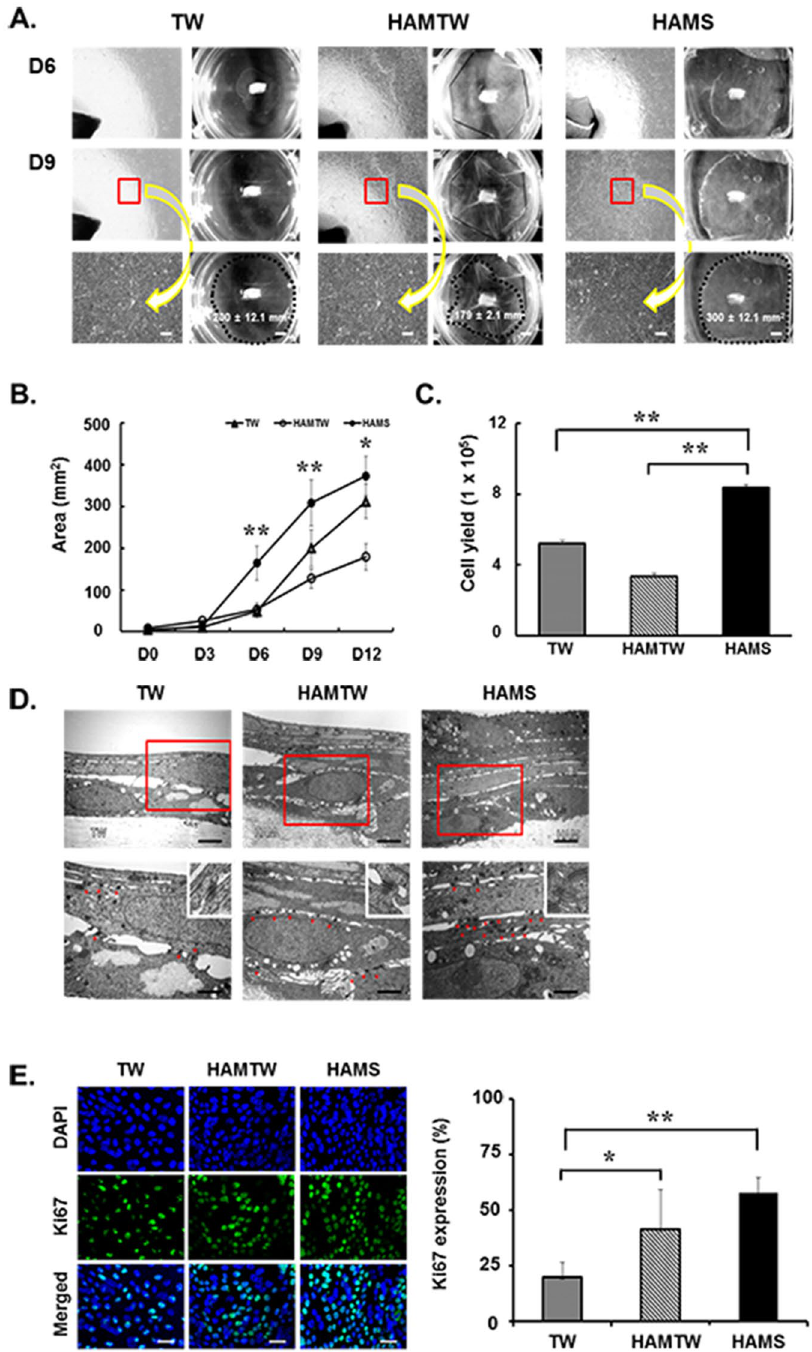
Figure 2. Limbal explant outgrowth sheets on substrate free, HAMTW, and HAMS. ( A ) Representative phase contrast micrographs of limbal explant outgrowth sheets on days 6 and 9 in TW, HAMTW, and HAMS. Bar = 50 µ m. Mean ± SD for six independent experiments from three donors are shown. ( B ) Area of limbal explant outgrowth sheets by day 12. ( C ) Cell yields after culture for 12 days. ( D ) Ultrastructure of limbal explant outgrowth sheets using transmission electron microscopy. The multi-layers (red insert) shown on top were observed under different magnifications on the bottom, respectively. The red stars demonstrated cell-cell junction spaces which were magnified on the top right of the pictures (bottom). Bar = 2 µ m (upper) and 0.2 µ m (lower). ( E ) Representative images of explant outgrowths stained for Ki67 and graph for Ki67 expressions. Bar = 20 µ m. * p < 0.05, ** p < 0.01 (n = 6 from 3